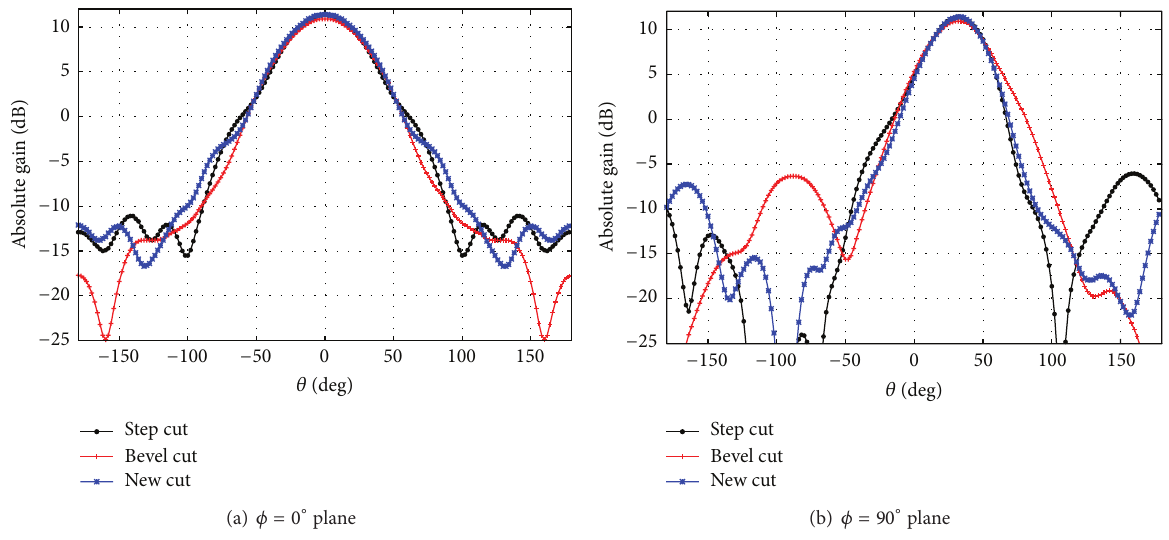
Figure 6: Comparison of the gain patterns of the step, the beveled, and the proposed Vlasov cuts.